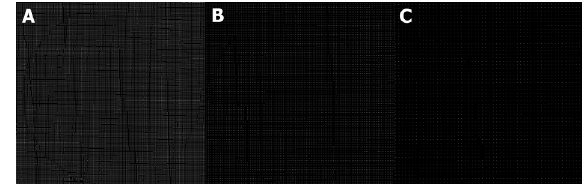
Fig ure 9. Point clouds of the test object, colour by intensity (greyscale) acquire from a 20 m distance, with resolution 1/1 (A), 1/2 (B) and 1/4 (C)